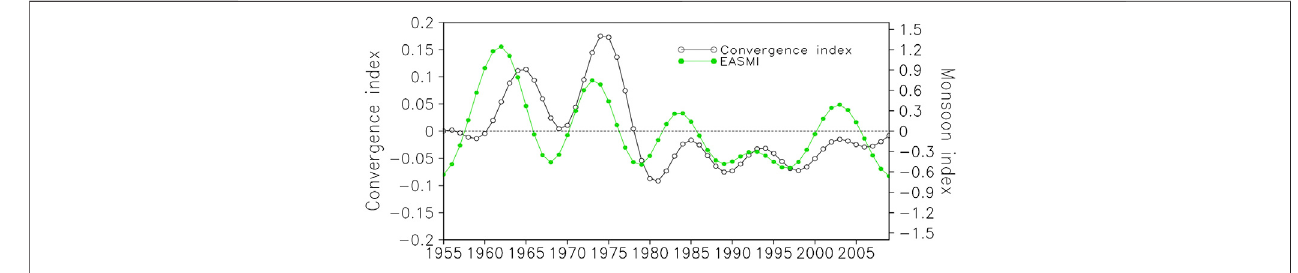
Frontiers in Earth Science |